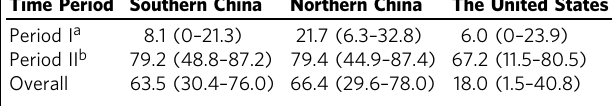
Table 1 Potential impact of COVID-19 outbreaks and non- pharmaceutical interventions on seasonal in fl uenza